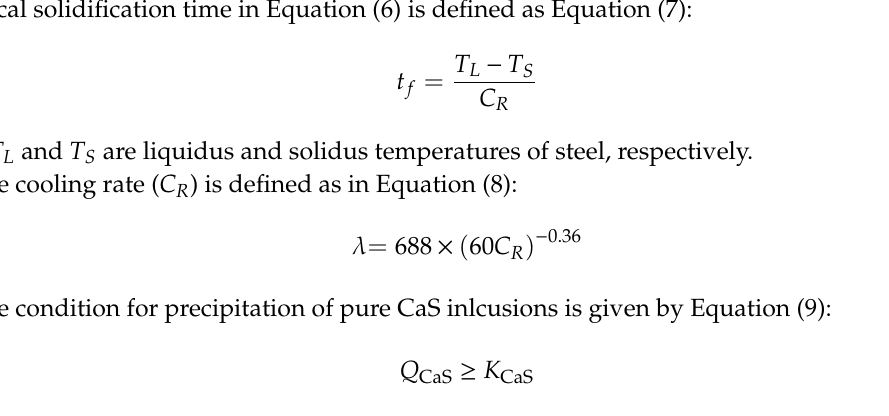
Table 5. Conditions for the calculation of CaS formation [33–35].